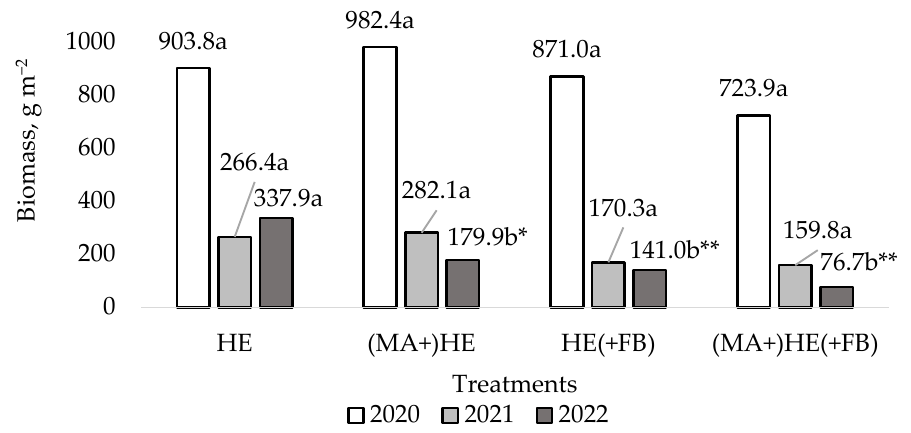
Figure 4. Impact of multi-cropping on dried hemp biomass, 2020–2022. HE: hemp single crop (control treatment), MA + HE: maize + hemp, HE + FB: hemp + faba bean binary crops, MA + HE + FB: maize + hemp + faba bean ternary crops. Different letters (a, b, c) within columns of separate vegetative season show significant difference between treatments at p ≤ 0.05; * significant differences from HE at p ≤ 0.05; ** at p ≤ 0.01.